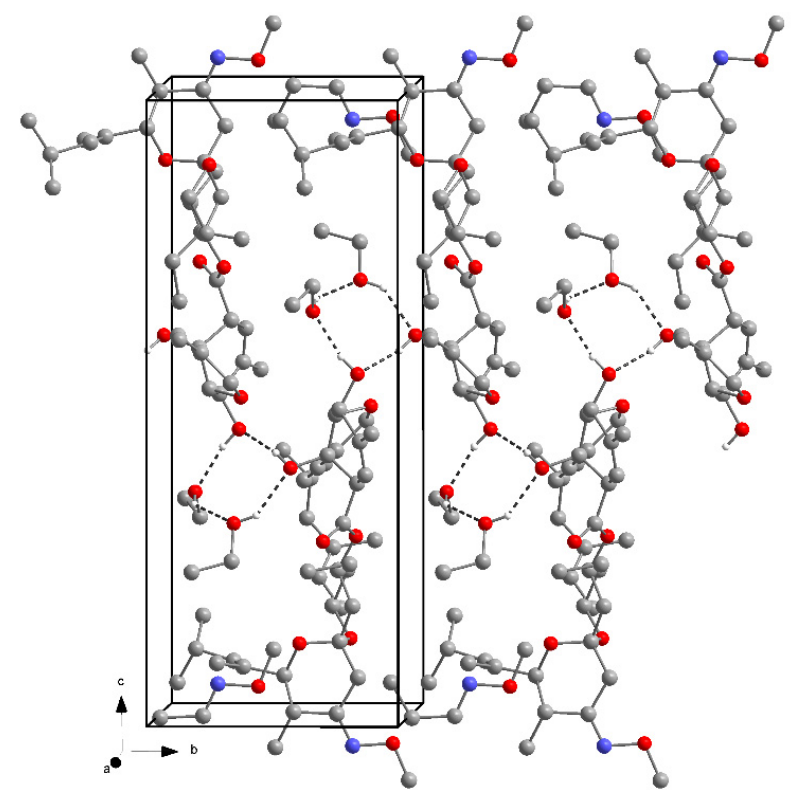
Figure 3. Representation of the chains along the crystallographic [010] direction formed by hydrogen bonds between the molecules in Moxi · 2ROH (R = Et, i Pr; exemplarily shown for the EtOH solvate). Color code: C, grey; N, blue; O, red; H, white.